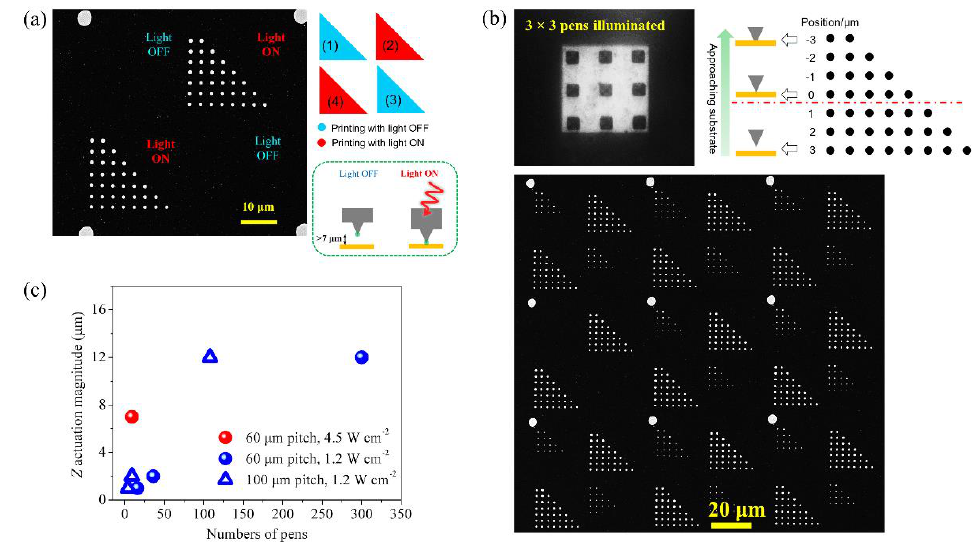
Figure 5. Localized photoactuation of the composite pens for molecular patterning. Visible light at 4.5 W cm −2 was used to drive 3 × 3 pens within a 2D array to engage the “paper” for active writing. ( a ) Scanning electron microscope (SEM) image of a representative pattern written by one of the illuminated pens. ( b ) SEM image of the pattern written by the illuminated pens. ( c ) The effect of the light intensity, illumination area, and the pitch of the pen array on the actuation resolution and magnitude.